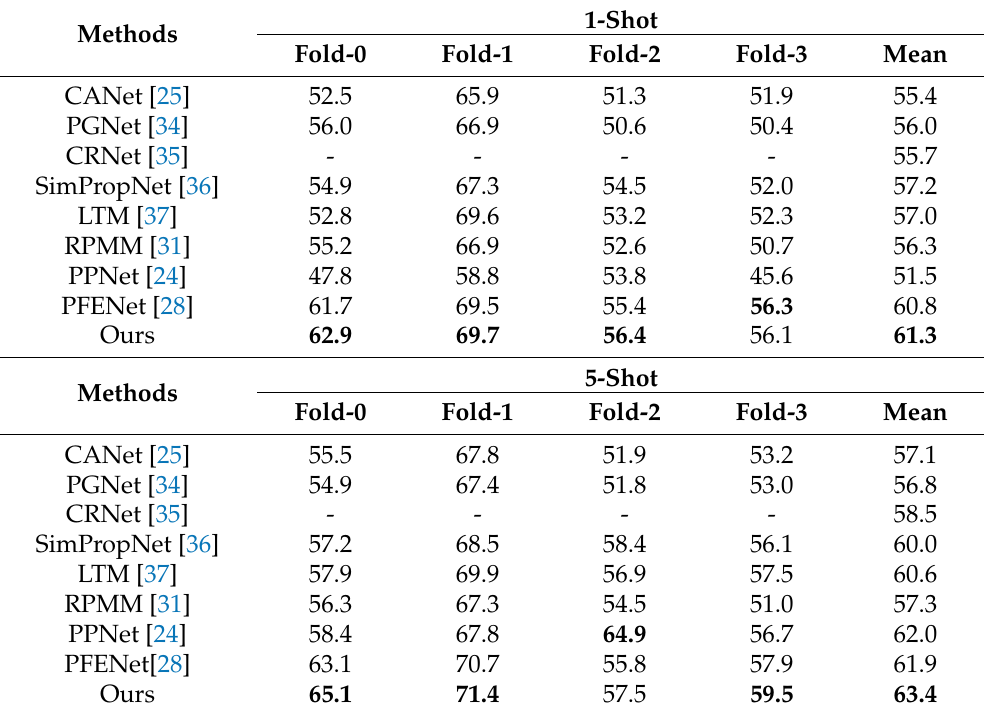
Table 4. Four-fold class mIoU results on ResNet-50 of PASCAL-5 i